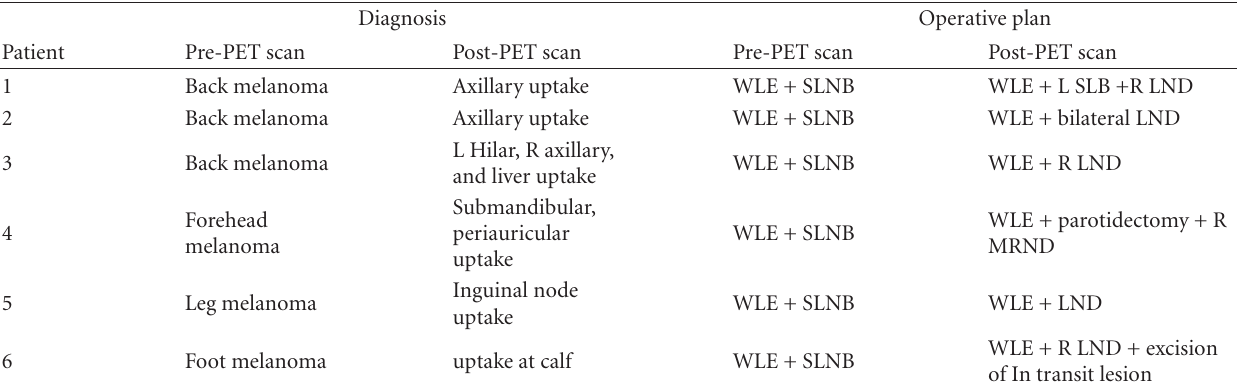
Table 2: Altered surgical plan based on PET.